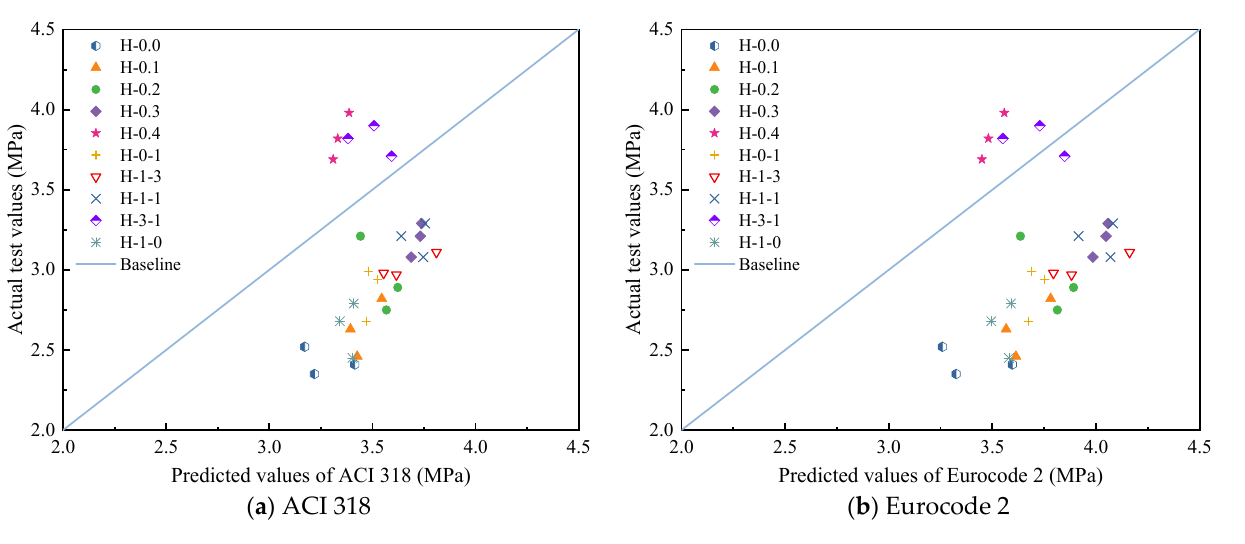
Figure 11. Comparison of test values and code predictions values of splitting tensile strength.